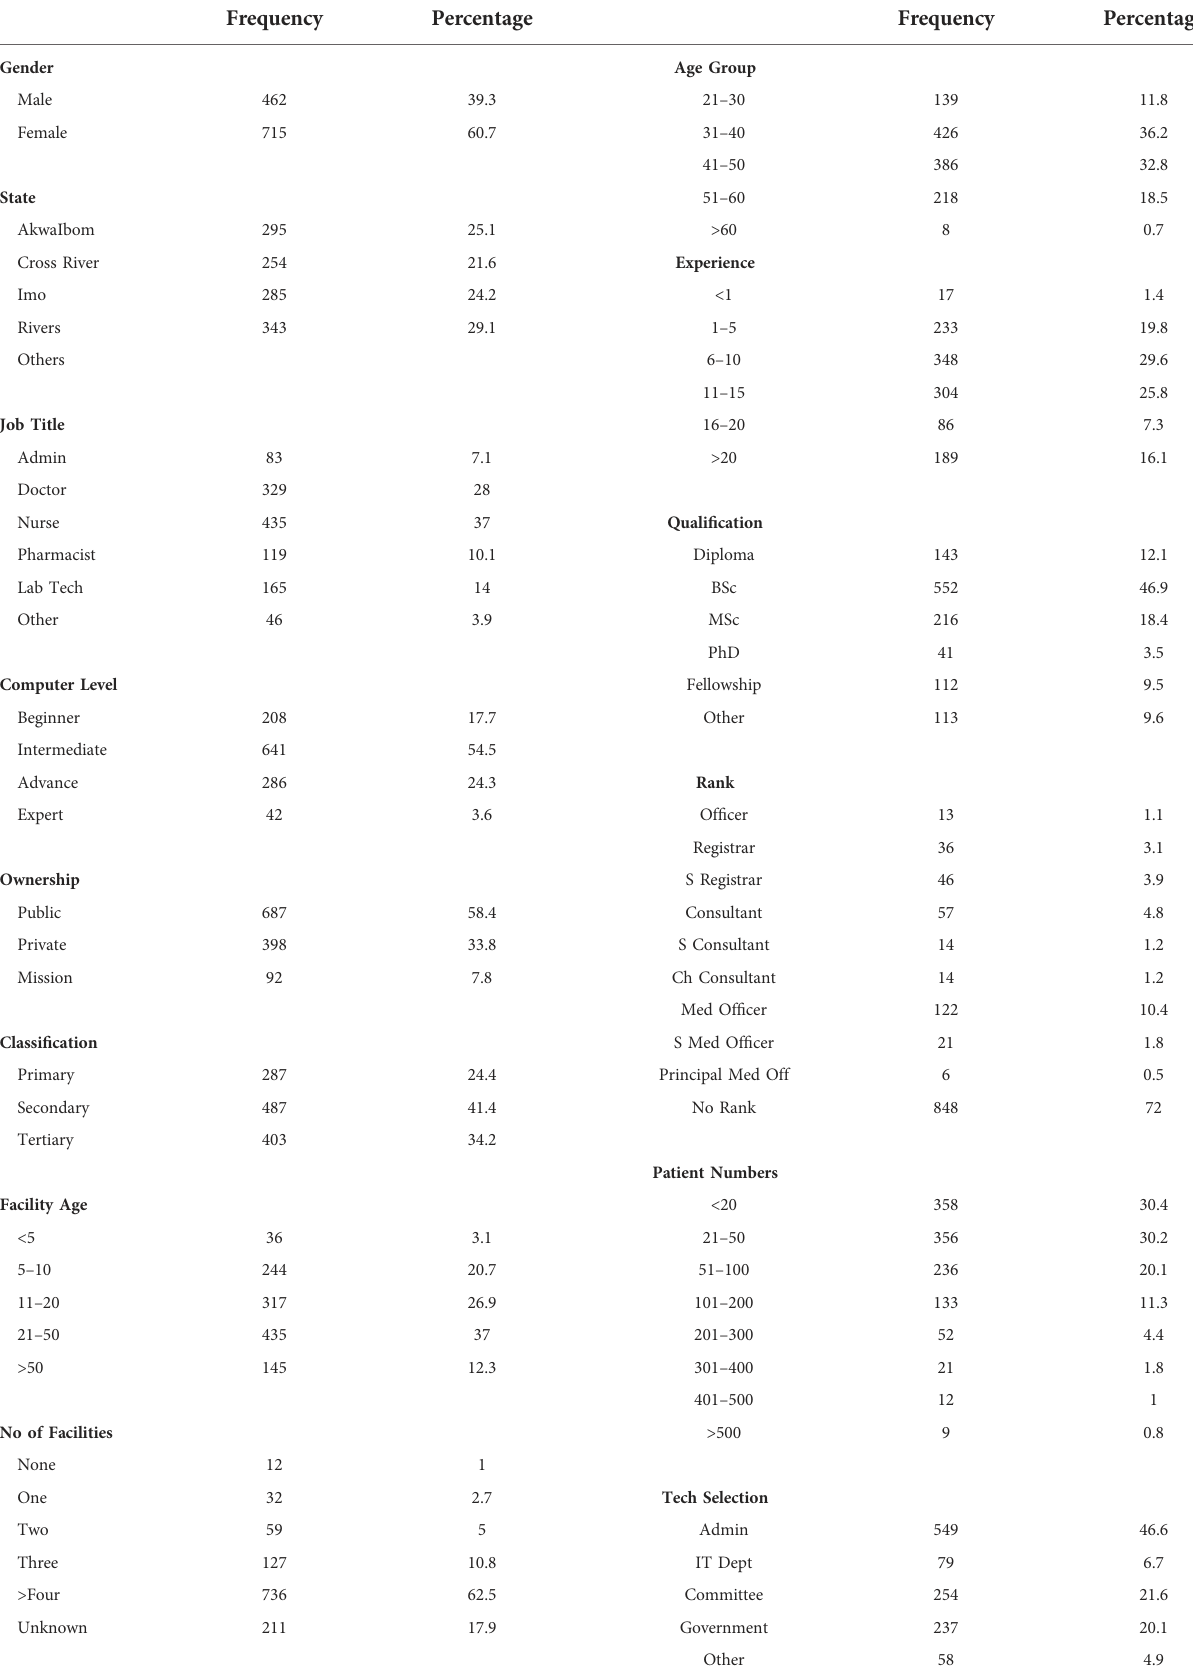
TABLE 1 Descriptive statistics ( N